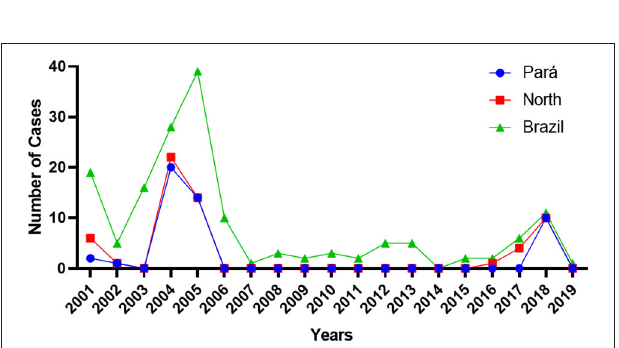
FIGURE 5 | Human rabies epidemiology in northern Brazil (2000–2018). It was reported 160 fatal cases in the period, with bat-transmitted outbreaks. Pará state has a central role in the northern region, representing 81% of the total confirmed